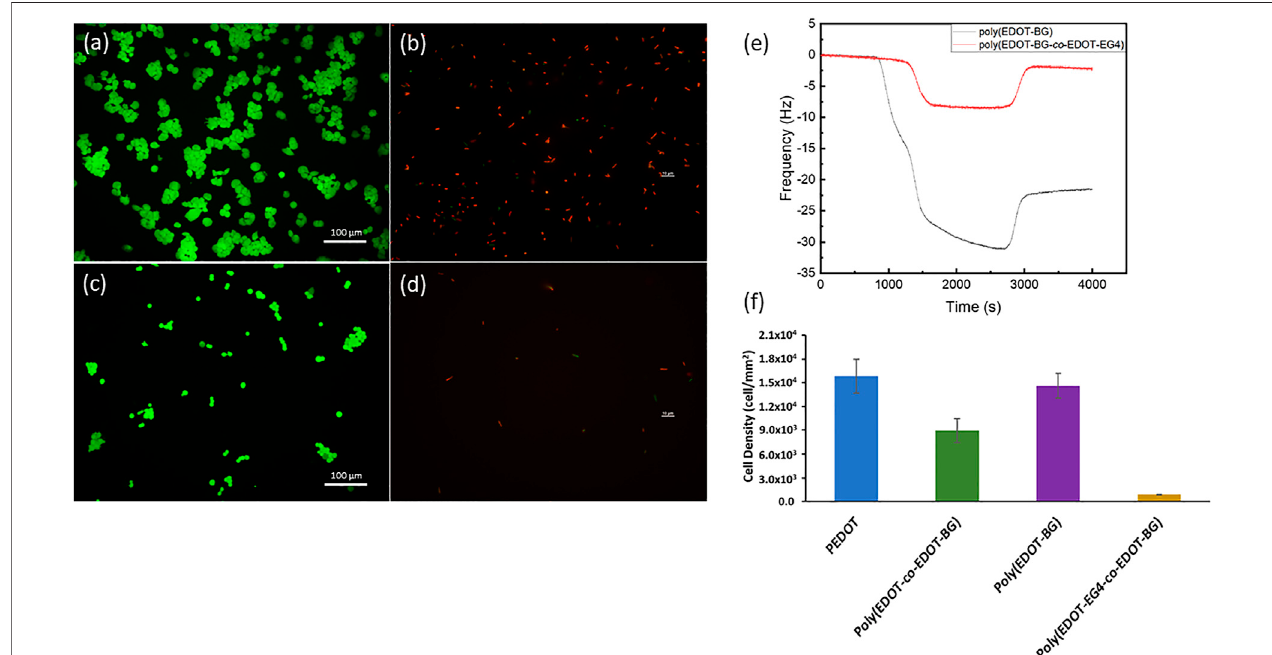
FIGURE 7 | Antifouling properties of the poly(EDOT-EG 4 - co -EDOT-BG) polymer from cell adhesion and protein adsorption studies. Representative fl uorescence microscopy image of HEK 293T cells (stained with green staining dye) attached on poly(EDOT-BG) (A) and poly(EDOT-EG 4 - co -EDOT-BG) polymers (C) ; fl uorescence microscopy image of E. coli (stained with red staining dye) attached on poly(EDOT-BG) (B) and poly(EDOT-EG 4 - co -EDOT-BG) (D) . QCM measurements for protein adsorptionon poly(EDOT-BG)and poly(EDOT-EG 4 - co -EDOT-BG) fi lms electrodepositedonagoldQCMcrystal (E) and quantitative celldensity ofHEK 293Tcells cultured for 48 h on PEDOT, poly(EDOT-BG), poly(EDOT- co -EDOT-BG), and poly(EDOT-EG 4 - co -EDOT-BG) polymers electrodeposited on ITO-glass slides (F) . The scale bar for Figures (B) and (D) is 10